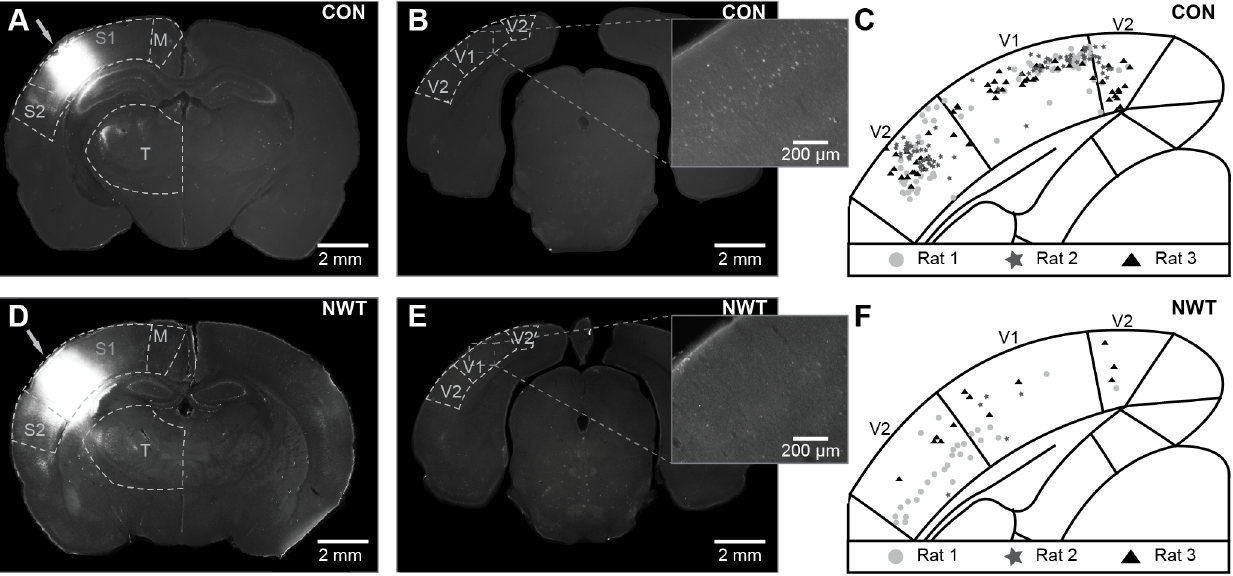
Fig 4. Direct connectivity between S1 and V1 of CON and NWT rats revealed by retrograde tracing with fluorogold. ( A ) Photomicrograph depicting FG spreading from the injection site (arrow) over all S1 layers in a 100 μ m-thick coronal slice of a CON rat. ( B ) Photomicrograph depicting retrogradely labeled neurons in V1 and V2 of the rat shown in (A). Inset, labeled V1 neurons displayed at higher magnification. ( C ) Diagram depicting the number and relative position of retrogradely labeled neurons in V1 and V2 of three CON rats (stars, circles, triangles). ( D ) Photomicrograph depicting FG spreading from the injection site (arrow) over all S1 layers in a 100 μ m-thick coronal slice of a NWT rat. ( E ) Photomicrograph depicting retrogradely labeled neurons in V1 and V2 of the rat shown in (D). Inset, labeled V1 neurons displayed at higher magnification. Note the low density of stained neurons over all cortical layers. ( F ) Diagram depicting the number and relative position of retrogradely labeled neurons in V1 and V2 of three NWT rats (stars, circles, triangles). The underlying data of this figure can be found in S1 Data. http://dx.doi.org/10.6084/m9.figshare.1540797